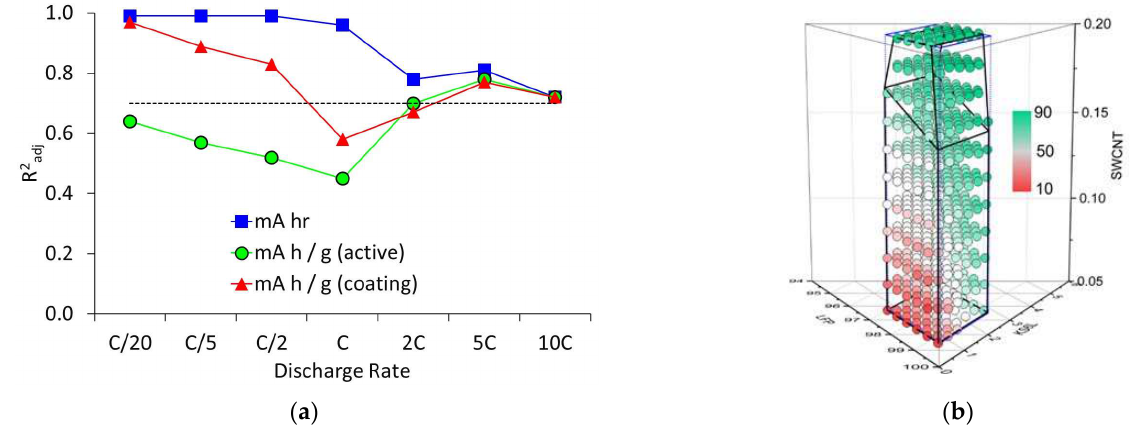
Figure 6. Calculations from the mixture + process model; ( a ) goodness of fit values, and ( b ) discharge capacities (mA h g −1 ) at 5C.